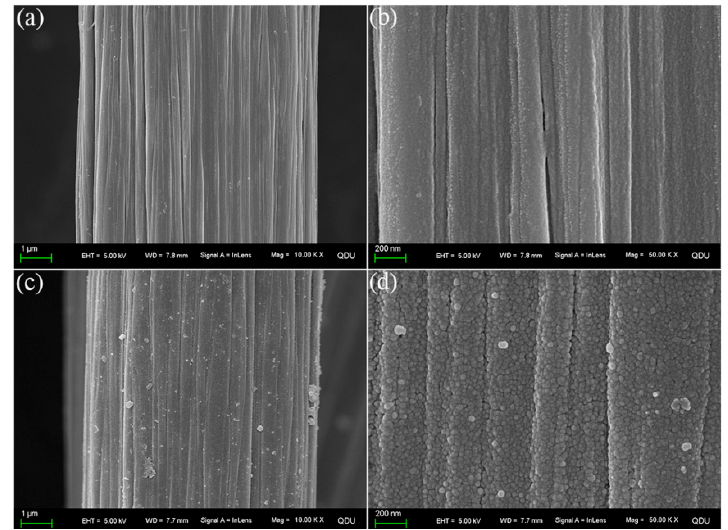
ff erent CFs surfaces: ( a , b ) CF / PDA and ( c , d ) CF / PDA / SiO Figure 3. SEM images of different CFs surfaces: ( a , b ) CF/PDA and ( c , d ) CF/PDA/SiO 2 . Figure 3. SEM images of di